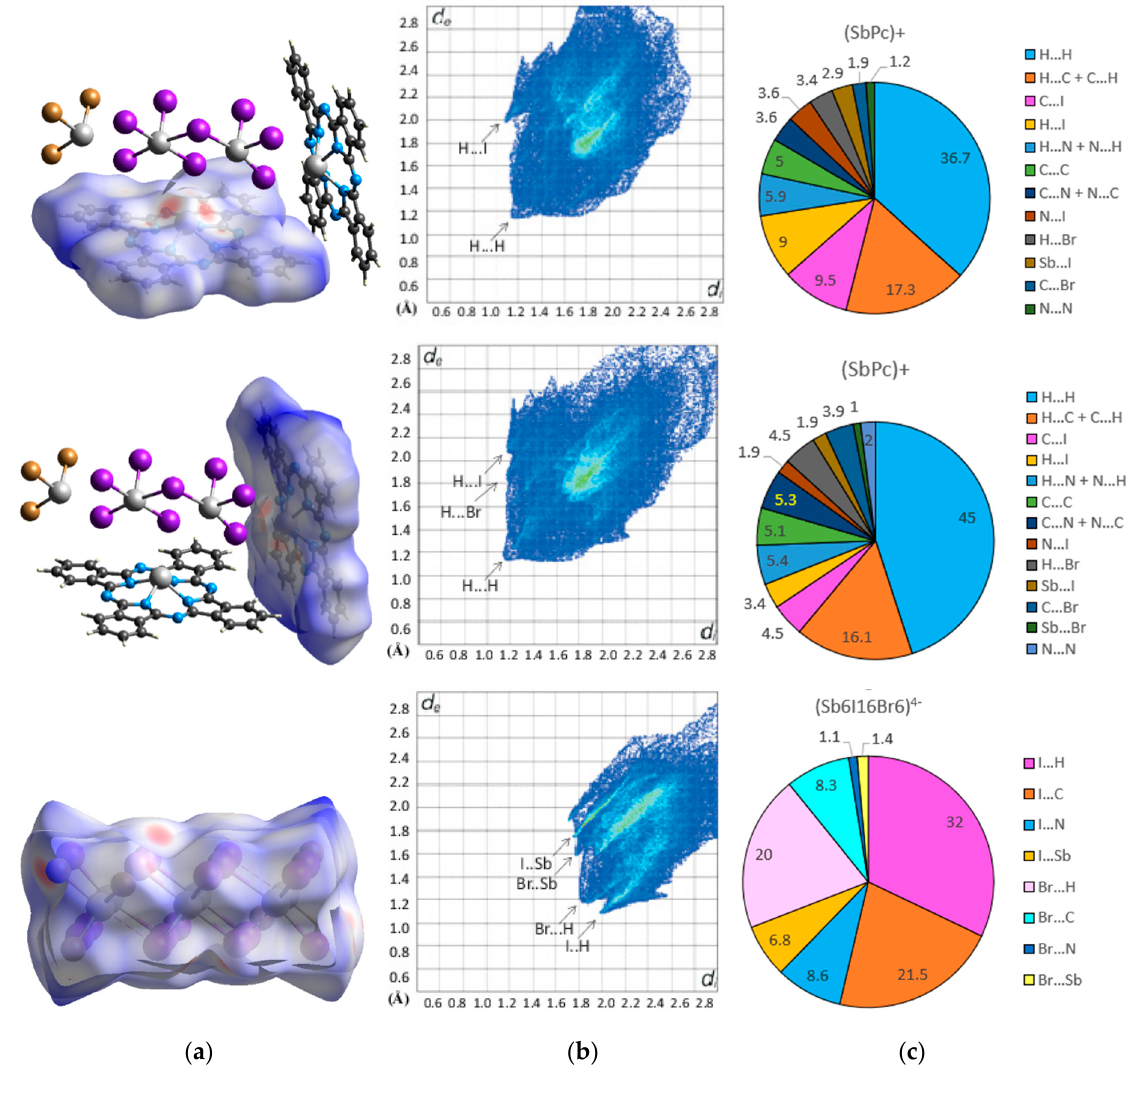
Figure 5. Hirshfeld surface ( a ) and the 2D-fingerprint plots ( b ) for each building units of the crystal 1 and ( c ) percentage contributions of the respective interactions in the